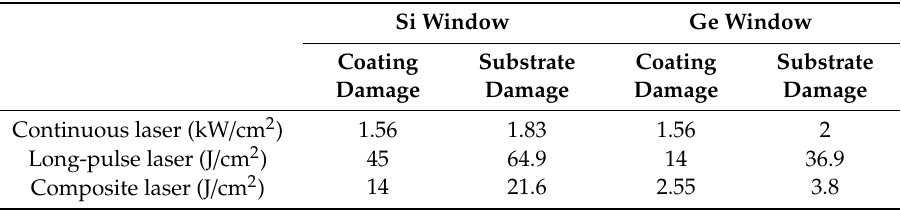
Table 10. Comparison of the damage thresholds of di ff erent